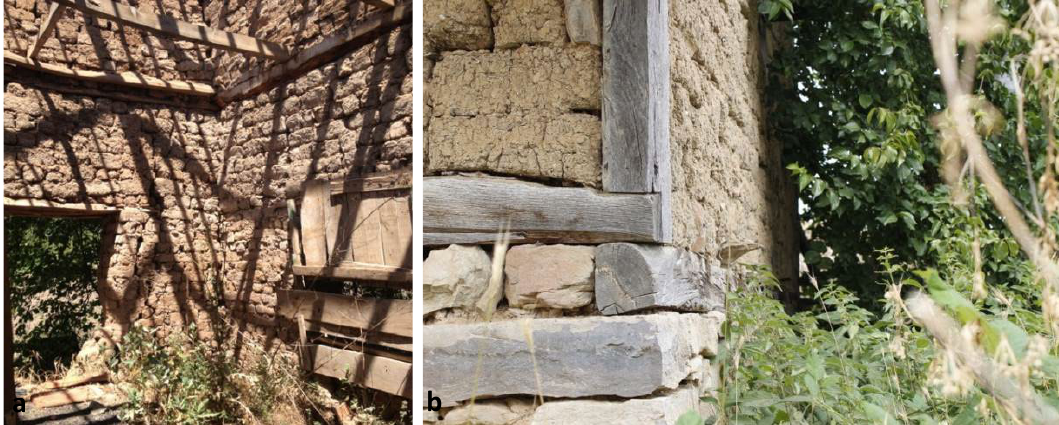
Figure 15 A Wooden beams and adobe blocks b Structure details in adobe system (photos: